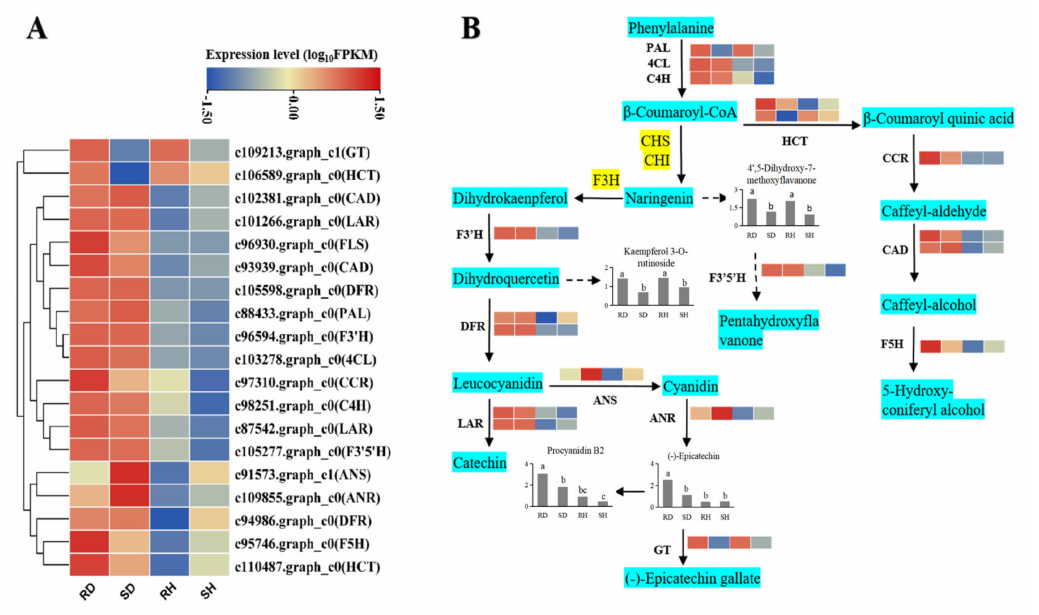
Figure 7. Expression of candidate genes involved in flavonoid biosynthesis. ( A ) The expression profile of key genes among the four sample groups, data of each row was standardized. ( B ) The postulated biosynthetic pathway of flavonoids after Co. gloeosporioides infection. The four squares in each horizontal row correspond to the four sample groups. The light blue boxes indicate different enzymes. The bar graph represents the relative metabolic